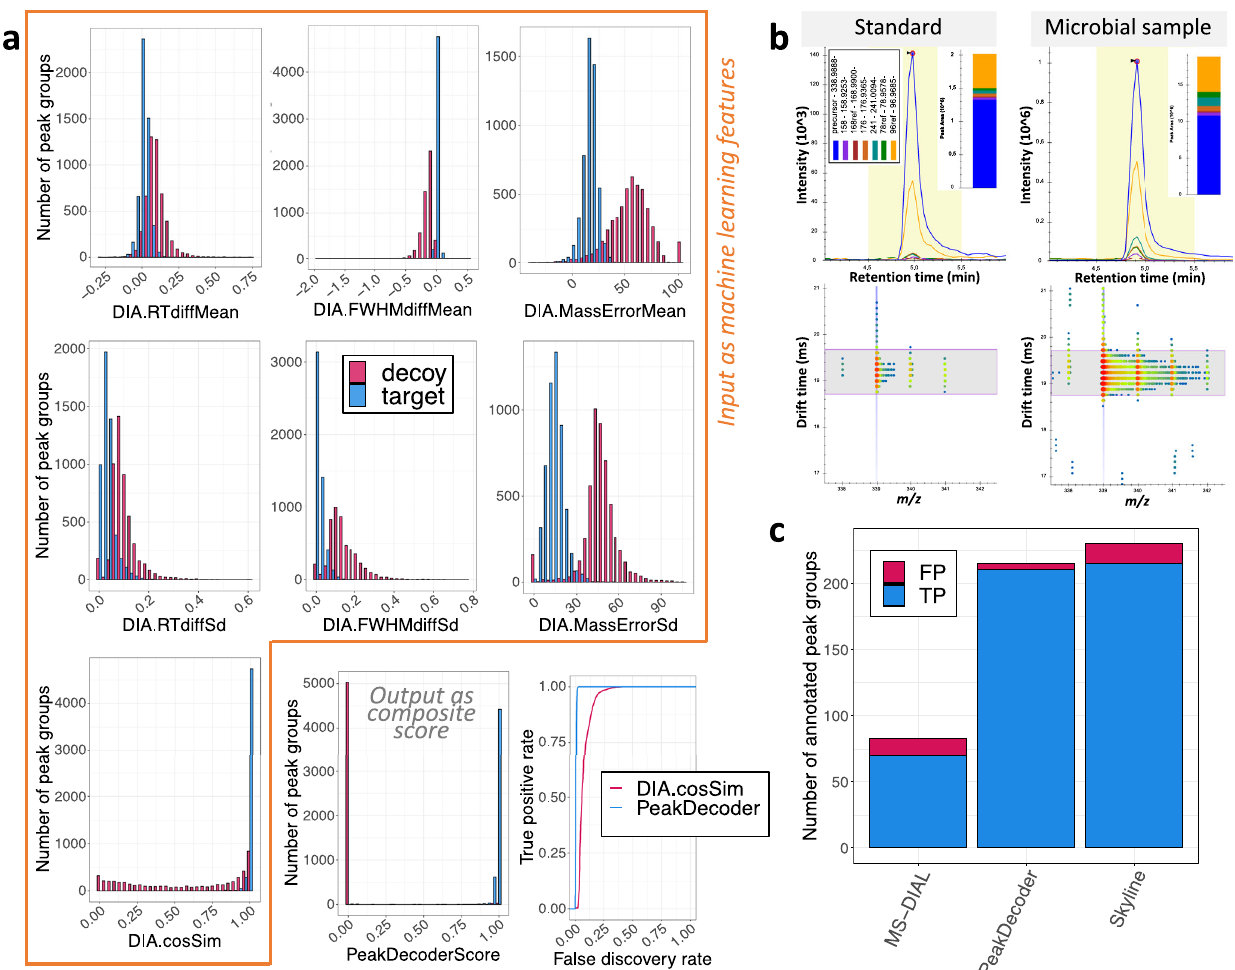
Fig. 3 | Analysis of microbial samples by LC-IM-MS using PeakDecoder. a Comparisonofscoresintraining.Targetsanddecoysarerepresentedbyblueand red colors, respectively. Distributions of LC-IM-MS peak-groups by each individual score (highlighted in orange) showed limited separation of targets and decoys. Individual scores used as machine learning features were combined into the composite PeakDecoder score providing an improved separation power and resulted in a larger number of true positives for lower FDR thresholds than the cosine similarity score, which is the best score individually. b Example of chro- matograms and fi ltered ion mobility window. Signals for ‘ fructose 1,6-diphosphate (F16DP) ’ fromthestandard(precursor m/z 338.98877,RT4.95min,CCS155.00and 6 fragments) and corresponding peaks from a microbial sample (annotated by